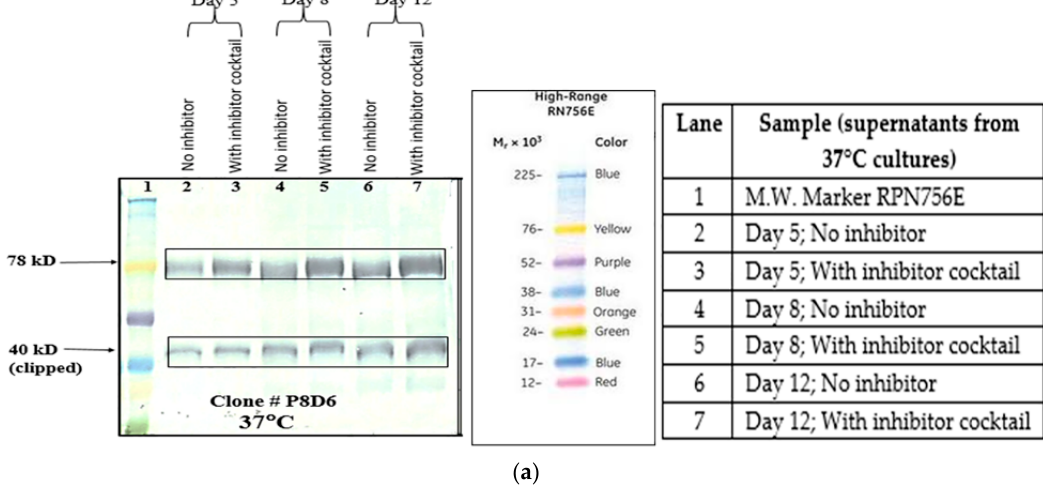
Figure 3. Cont. Figure 3.